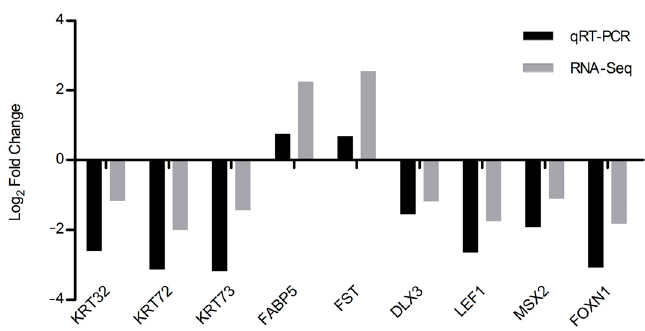
Figure 7. Validation of the RNA-Seq results of nine DEGs with qRT-PCR.